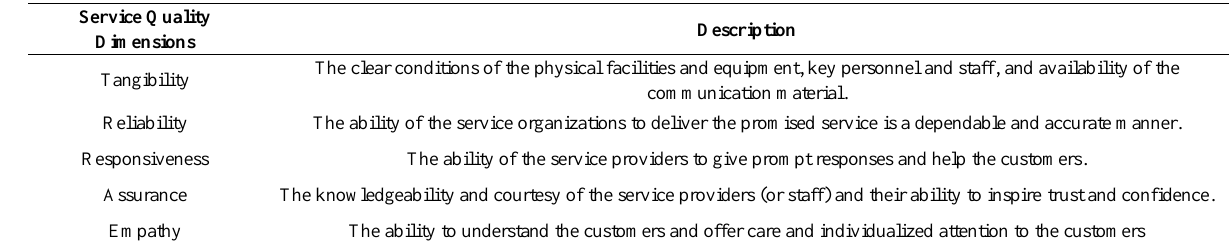
Table 3. SERVQUAL dimensions